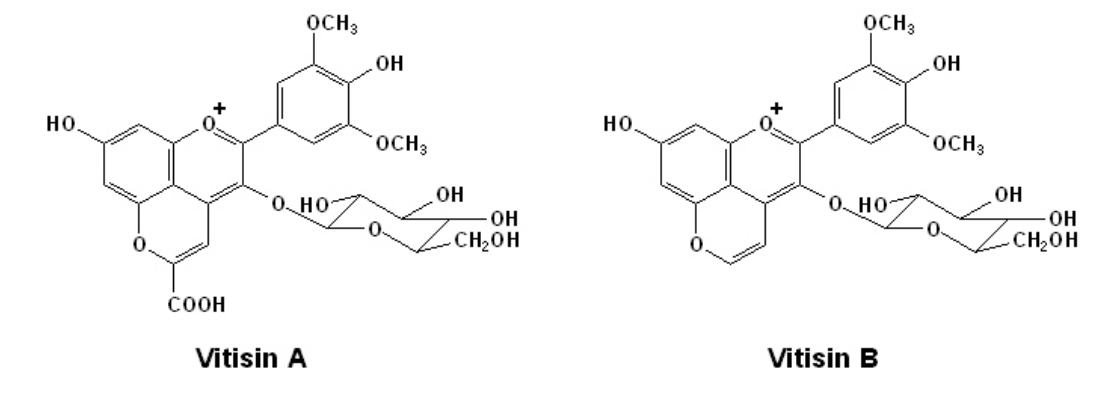
Figure 3. Structures of vitisin A and vitisin B